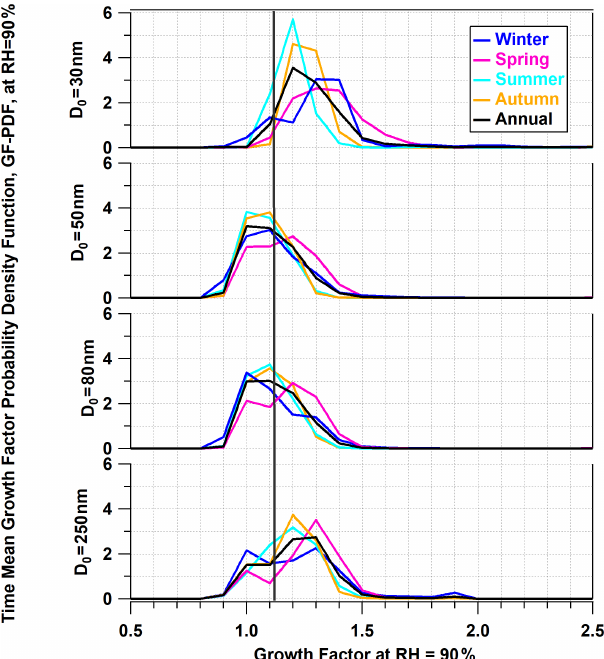
Figure 4. Seasonal and annual mean GF-PDFs for different dry particle sizes (30, 50, 80 and 250nm). The vertical black line repre- sents the selected cutoff between the non- and/or slightly hygro- scopic mode (GF < 1.12) and the moderately hygroscopic mode (GF >